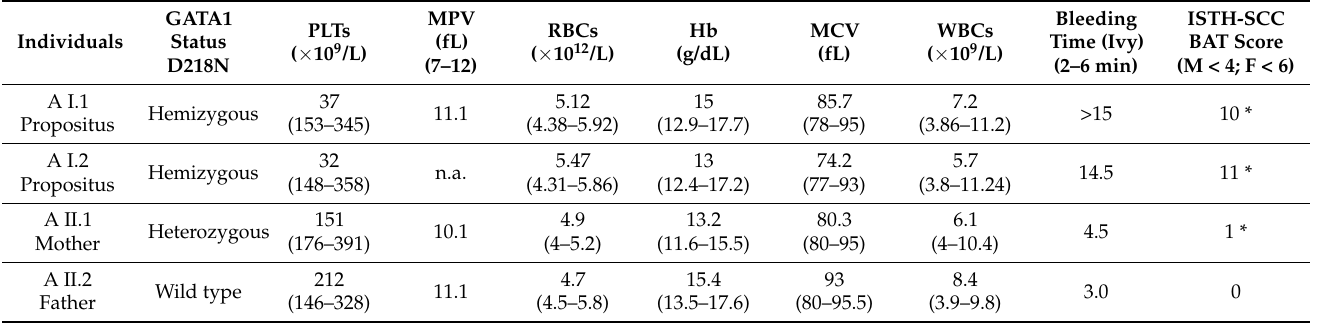
Table 1. Pedigree A, laboratory values.